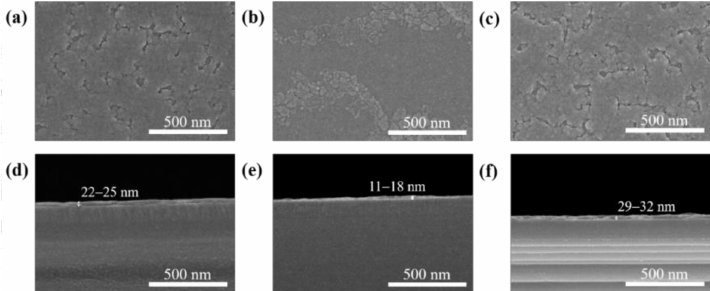
Figure 3. Surface and cross-sectional field-emission scanning electron microscopy (FE-SEM) images of the single-layer ( a , d ) In 2 O 3 and ( b , e ) ZnO films, and ( c , f ) bilayer ZnO/In 2 O 3